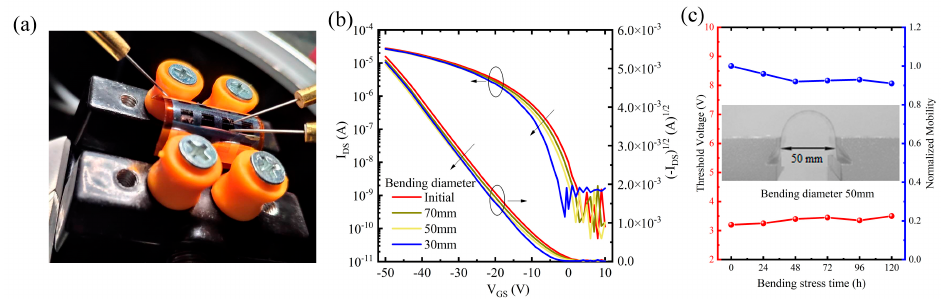
Figure 5. (a) Flexible OFETs based on PVP:CaTiO 3 NPs/PVP composite dielectric with a PI substrate during a bending test. (b) Transfer characteristics of Pentacene OFETs based on PVP:CaTiO 3 NPs/PVP composite dielectric when bending diameter at initial, 70 mm, 50 mm, 30 mm, respectively. (c) Evolution of the mobilities and corresponding threshold voltages in OFETs bent at 50 mm under a constant strain.